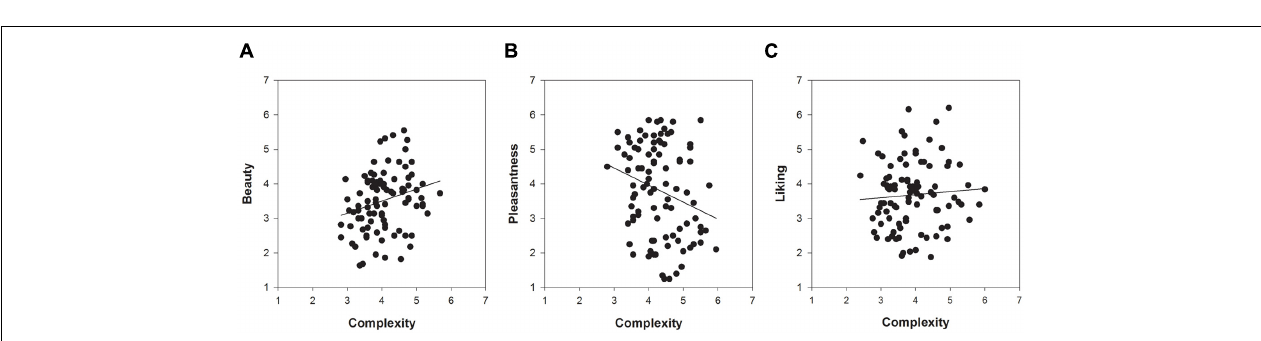
SD pleasantness = 0.77, M liking = 3.55, SD liking =